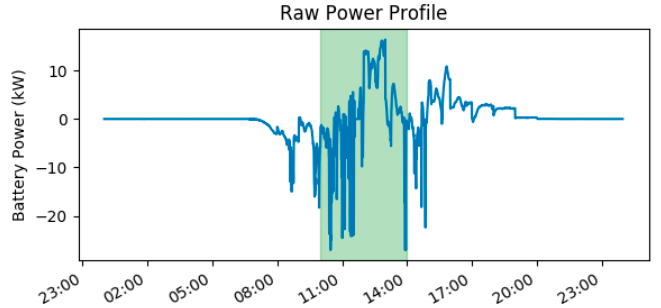
Figure 9. Power profile based on solar correction.